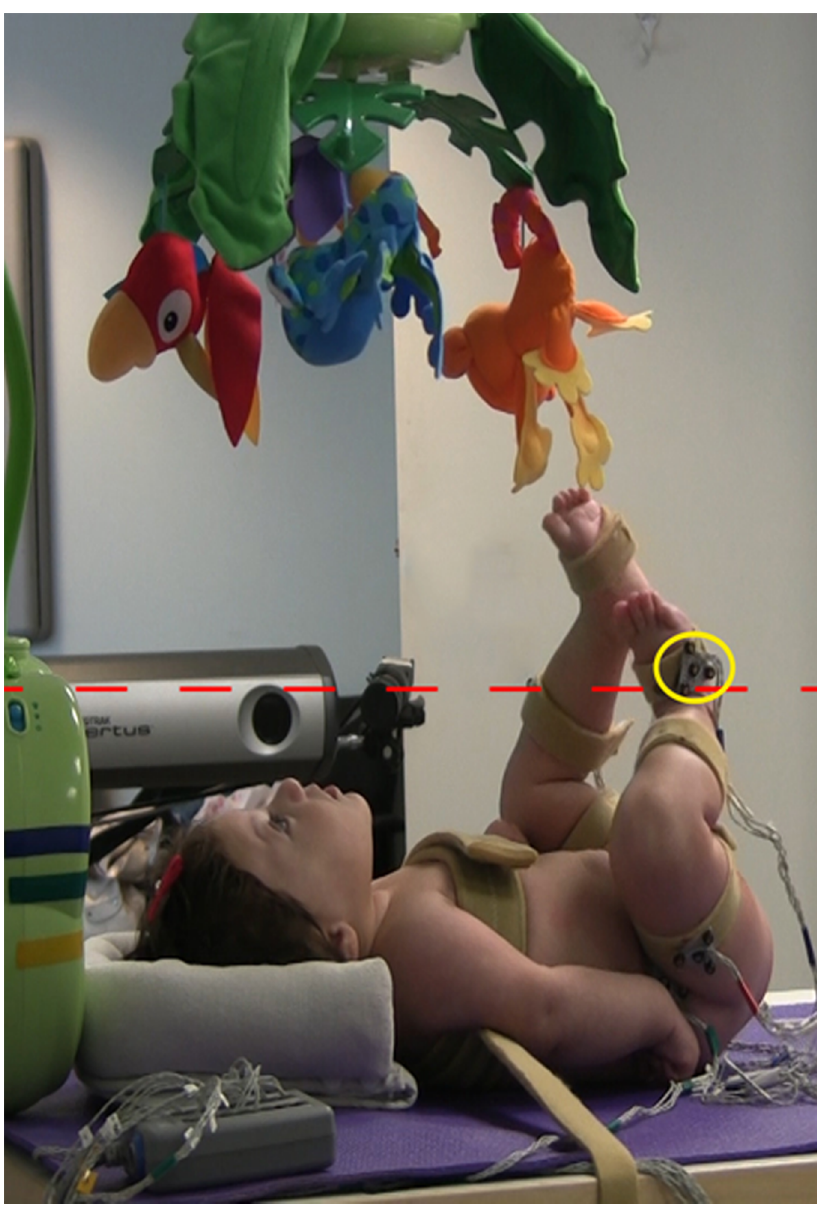
Figure 1. Infant mobile task set-up. Note the infrared light-emitting diode (IRED) placed on each foot (yellow circle) moving vertically to cross the virtual threshold (red dashed line) and activate the mobile. The parent of this child has given written informed consent (as outlined in PLOS consent form) to publish this picture.